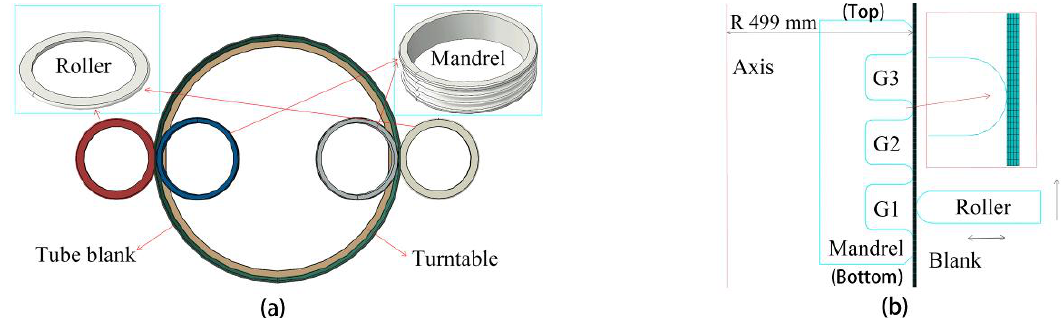
Figure 2. Numerical model for sheave counter-roller spinning. ( a ) 3D model; ( b ) 2D model. In ideal circumstances, the groove depth should be the same as the spinning depth, 5.2 mm.